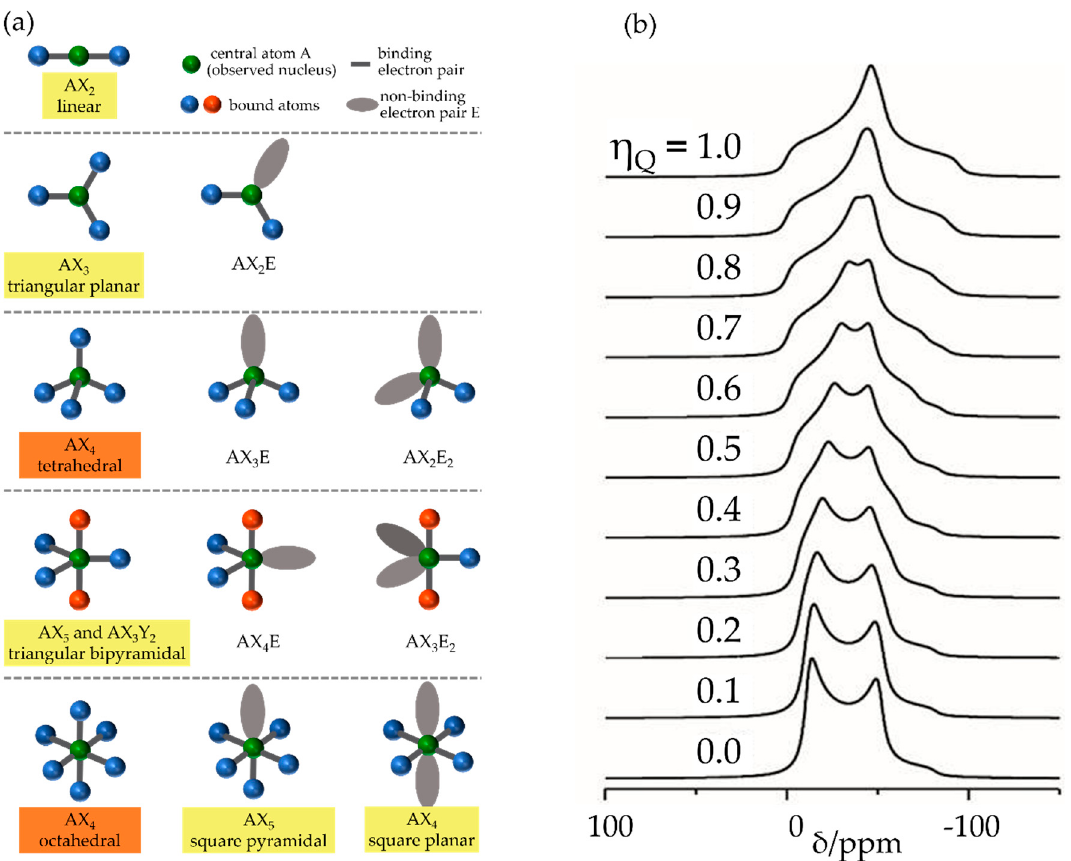
Figure 4. ( a ) Typical bonding geometries realized in molecular inorganic chemistry and characterization of their local symmetries. Geometries underlined in orange produce isotropic magnetic shielding tensors ( Δ σ = 0) and zero electric field gradients ( 𝑉 (cid:3053)(cid:3053) = 𝑉 (cid:3051)(cid:3051) = 𝑉 (cid:3052)(cid:3052) = 𝜂 (cid:3097) = 0; hence, 𝐶 (cid:3018) = 𝜂 (cid:3018) = 0 ) at the central nucleus under consideration. Geometries underlined in yellow produce axially symmetric magnetic shielding and EFG tensors ( 𝜂 (cid:3097) and 𝜂 (cid:3018) = 0). Geometries not underlined produce asymmetric magnetic shielding and electric field gradient tensors (0 ≤ ( 𝜂 (cid:3097) , 𝜂 (cid:3018) ) ≤ 1). ( b ) Typical MAS NMR line shapes predicted by second-order perturbation theory for the m = ½ < − > m = − ½ central transitions of half-integer spin nuclei due to quadrupolar interaction with EFGs of different 𝜂 (cid:3018) values.